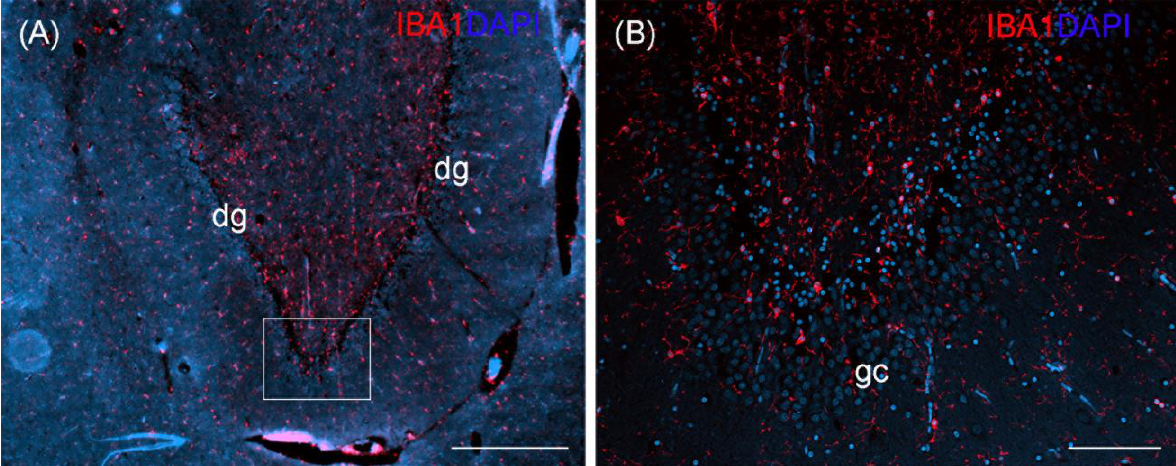
Figure 4. Ionized calcium-binding adapter molecule 1 (IBA1) staining of the hippocampal formation of an otter, coronal section, showing the dentate gyrus (dg) ( A ). White rectangle in ( A ) indicates the area of close-up ( B ) showing granular cells (gc). DAPI, 4′, 6 -diamidino-2-phenylindole nuclear staining. Scale bar equals 500 µm in ( A ), 100 µm in ( B ).